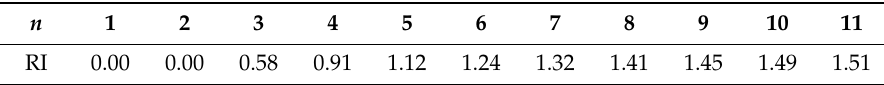
Table 3. Average random consistency index